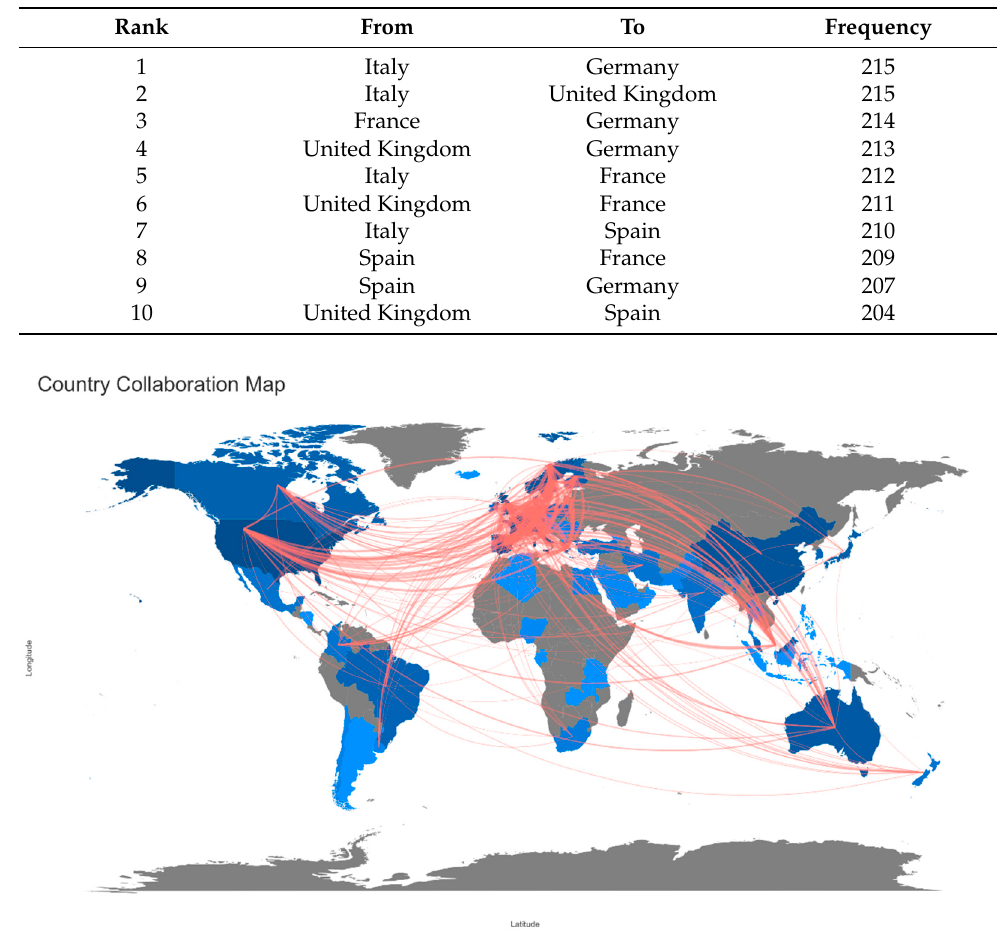
Figure 5. World map of country collaboration.